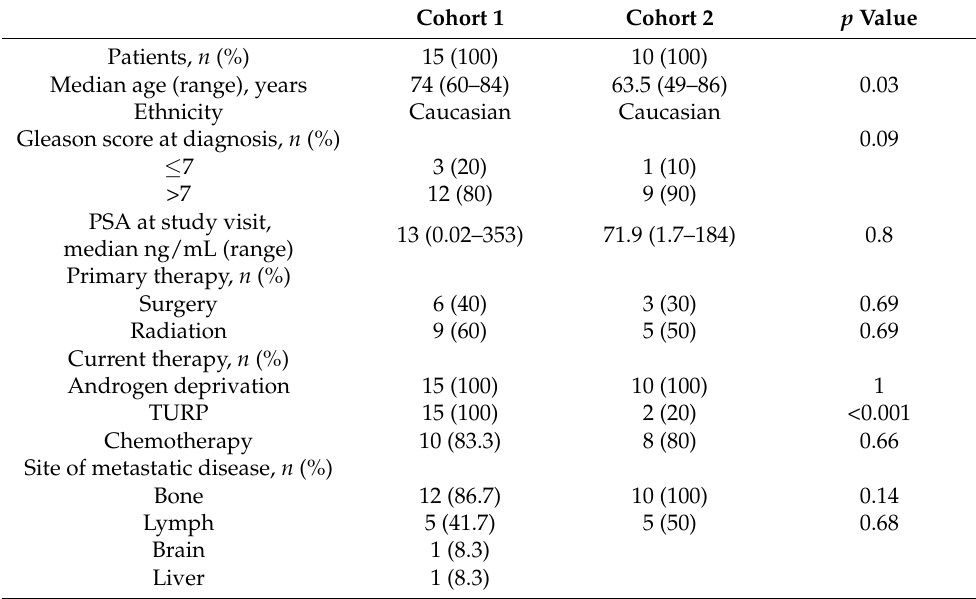
Table 1. Clinical characteristics of the metastatic prostate cancer patients in cohorts 1 and